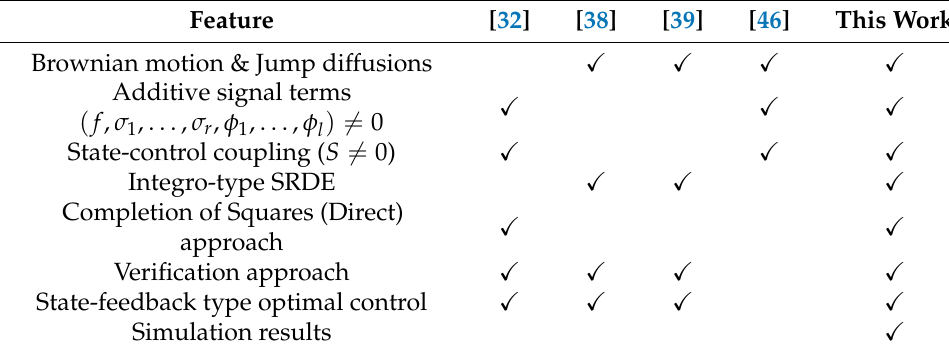
Table 1. Efficiency of the Proposed